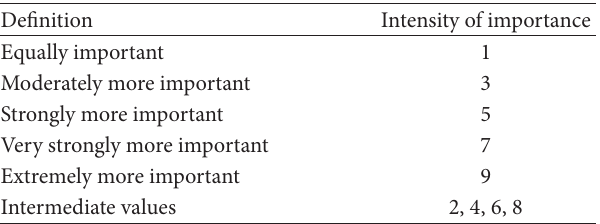
Table 11: Nine-point intensity of importance scale and its descrip-